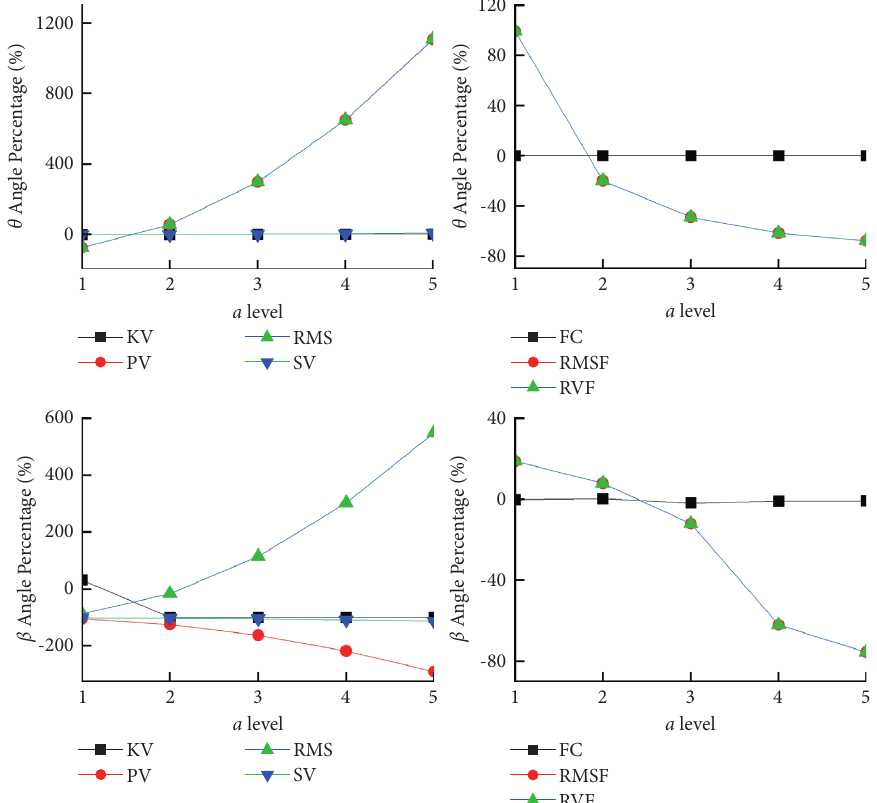
Figure 15: Effect of the swing acceleration on the lifting-swing angle.